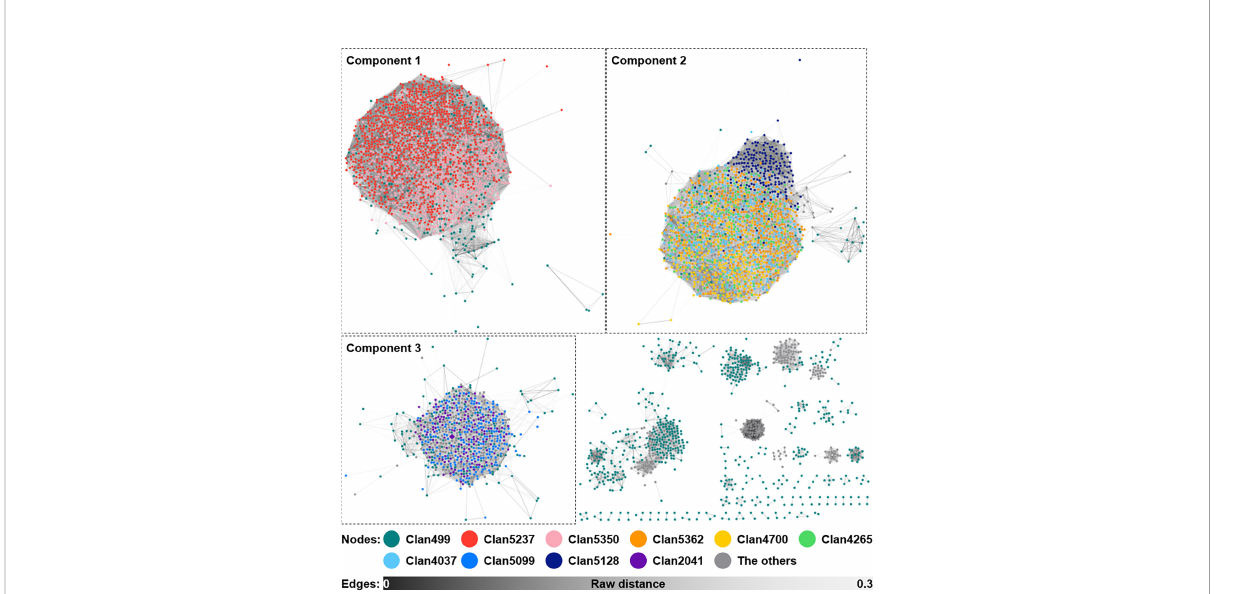
FIGURE 6 Sequence similarity network of siderophore BGCs predicted from the 2,062 Streptomyces genomes. A total of 5,217 siderophore BGCs, excluding 151 singletons, from 2,062 Streptomyces genomes are shown as a similarity network. Nodes belonging to the top 10 largest clans are fi lled with different colors as shown in the fi gure. Edges are shown in the color gradient denoting the raw distance retrieved from the BiG- SCAPE analysis. The top three largest components, to which BGCs of strain V17-9 belonged, are shown with the dashed boxes. BGCs, biosynthetic gene